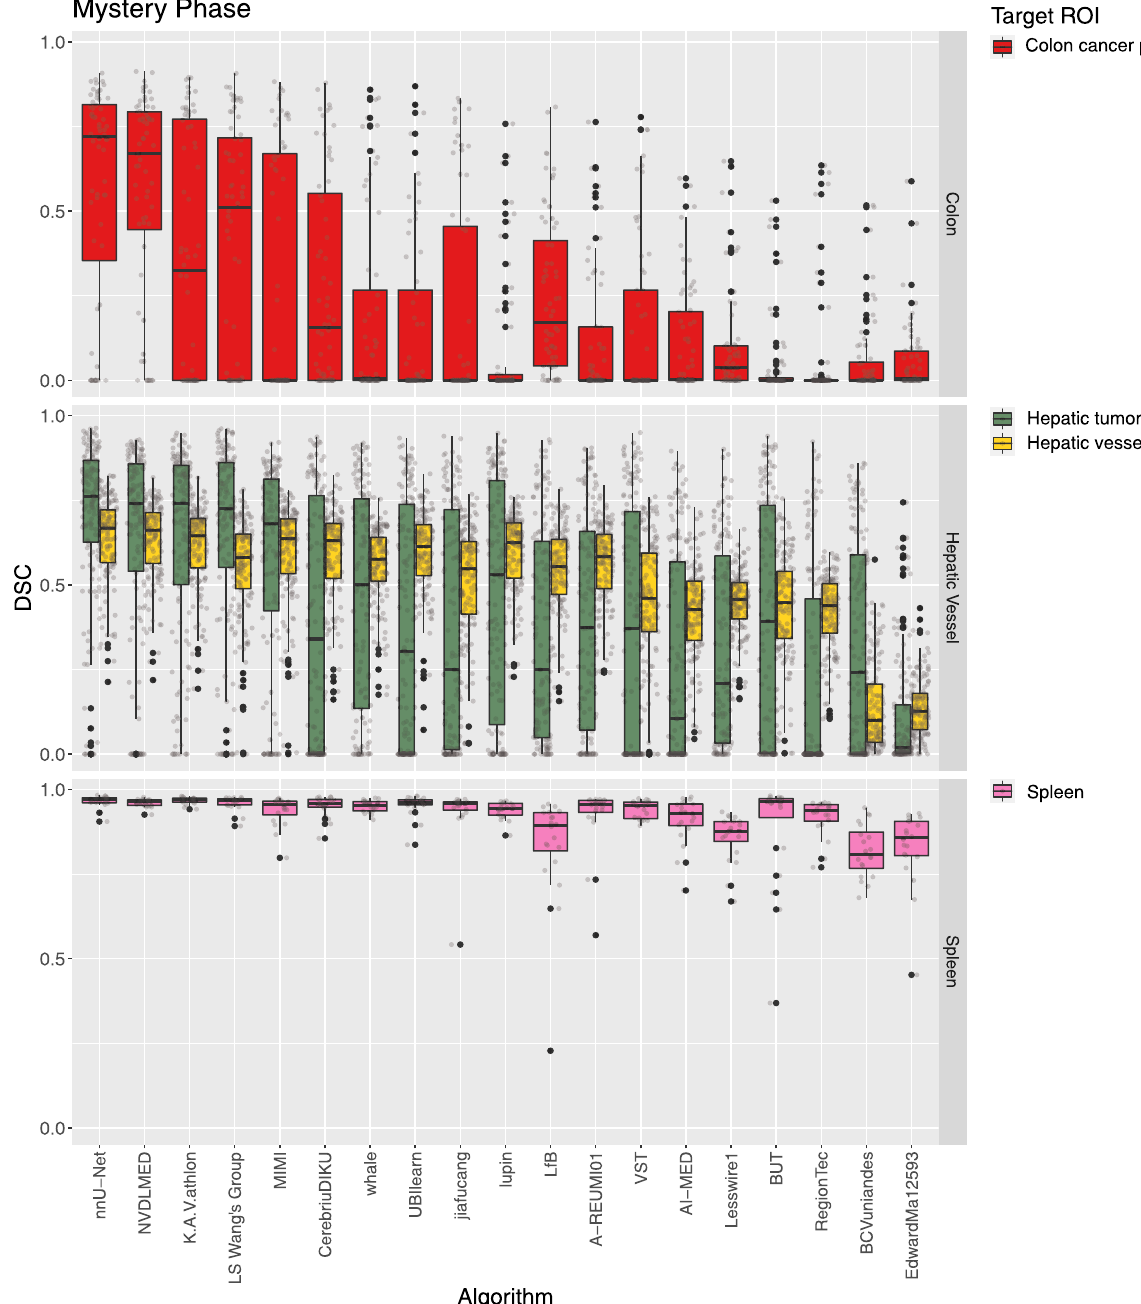
Fig. 4 Dot- and box-plots of the Dice Similarity Coef fi cient (DSC) values of all 19 participating algorithms for the three tasks of the mystery phase (colon, hepatic vessel, spleen), color-coded by the target regions (colon cancer primaries (red), hepatic tumor (green), hepatic vessel (yellow), spleen (pink)). The box-plots represent descriptive statistics over all test cases. The median value is shown by the black horizontal line within the box, the fi rst and third quartiles as the lower and upper border of the box, respectively, and the 1.5 interquartile range by the vertical black lines. Outliers are shown as black circles. The raw DSC values are provided as gray circles. ROI Region of ranks was achieved for team nnU-Net (minimum rank: 1, maximum rank: 4; the development phase) and the largest rank difference of sixteen ranks is obtained for team Whale (minimum rank: 2, maximum rank: 18; the development phase).